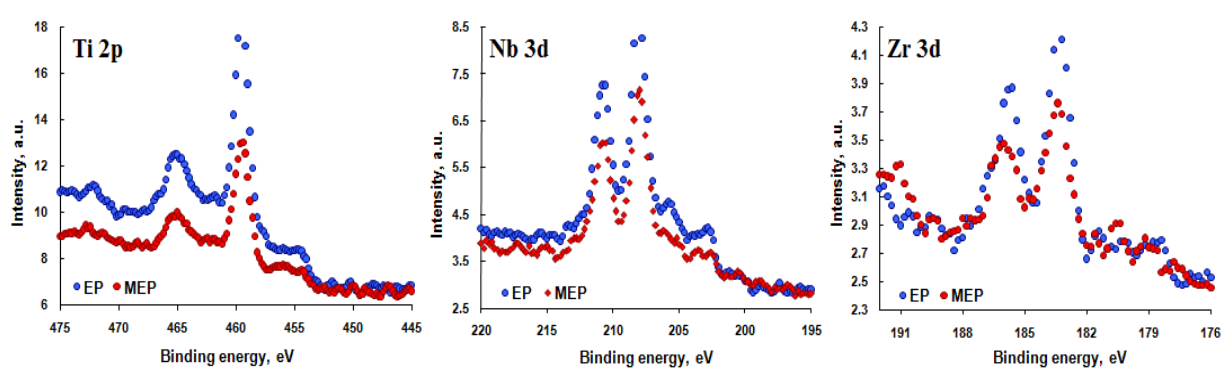
Figure 3. XPS high resolution Ti 2p, Nb 3d and Zr 3d spectra of TNZ alloy sample surface after EP and MEP.